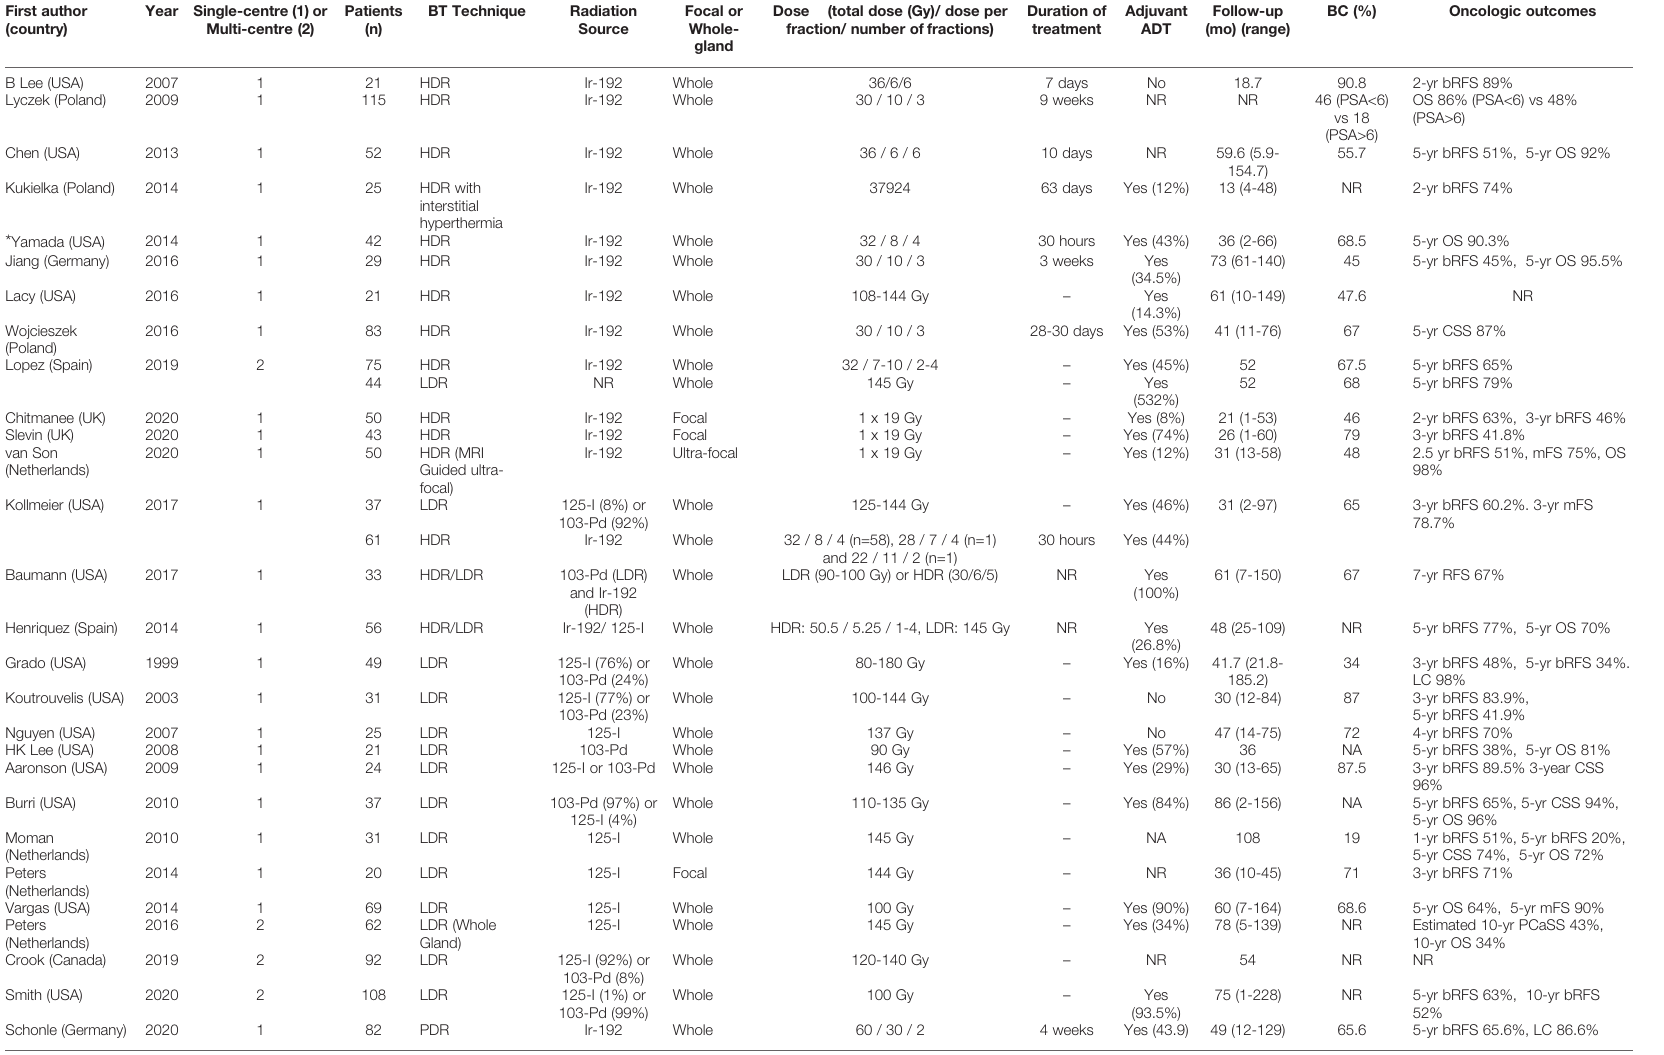
TABLE 6 | Salvage therapy details for BT studies. First author